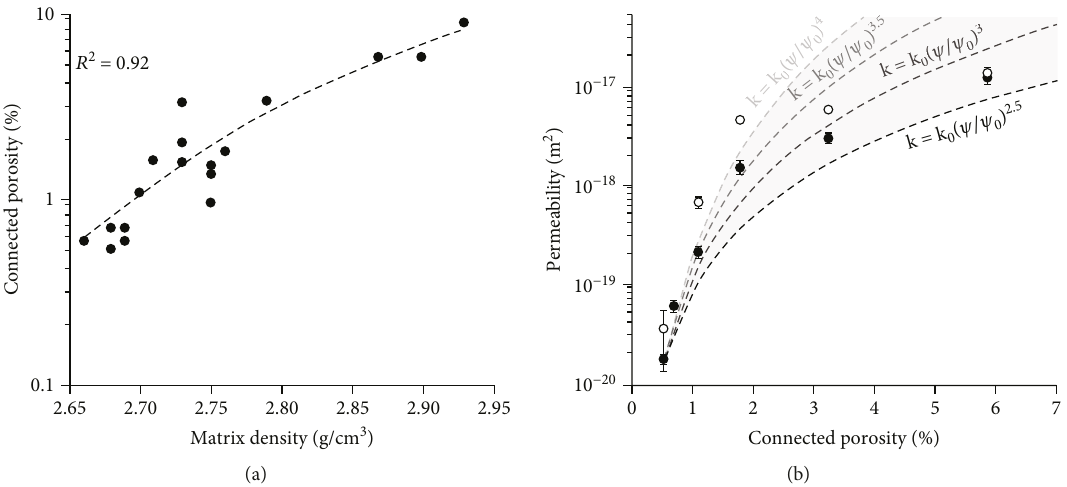
Figure 11: (a) Relationship between matrix density and connected porosity deduced from measurements performed on the Panasqueira granite-greisen samples. (b) Relationship between connected porosity and permeability deduced from granite greisen samples in which porosity and permeability were measured. Black and white dots correspond, respectively, to permeability values obtained at 25 ° C and 400 ° C. The dashed line corresponds to modeled evolutions of permeability as a function of rock porosity using power law equations (see text for